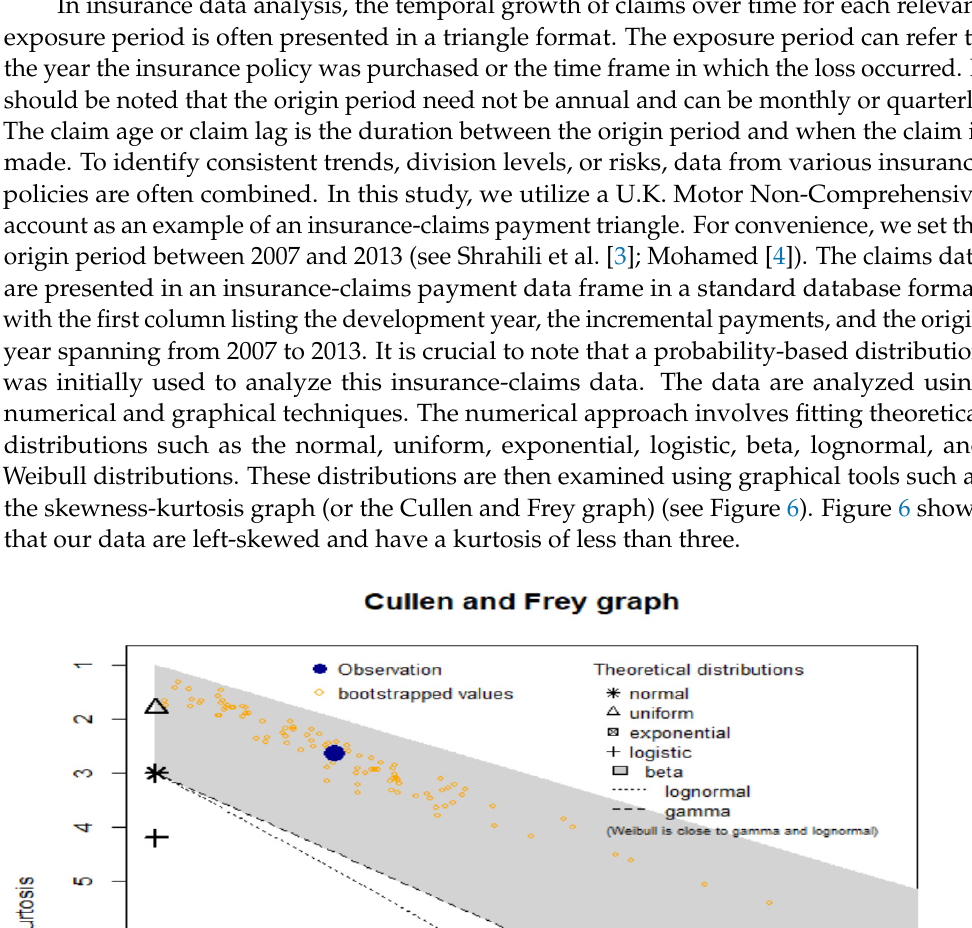
Figure 5. Estimated CDF ( top left ), estimated PDF ( top right ), P-P graph ( bottom left ), and Kaplan– Meier survival ( bottom right ) for the 2 nd dataset.